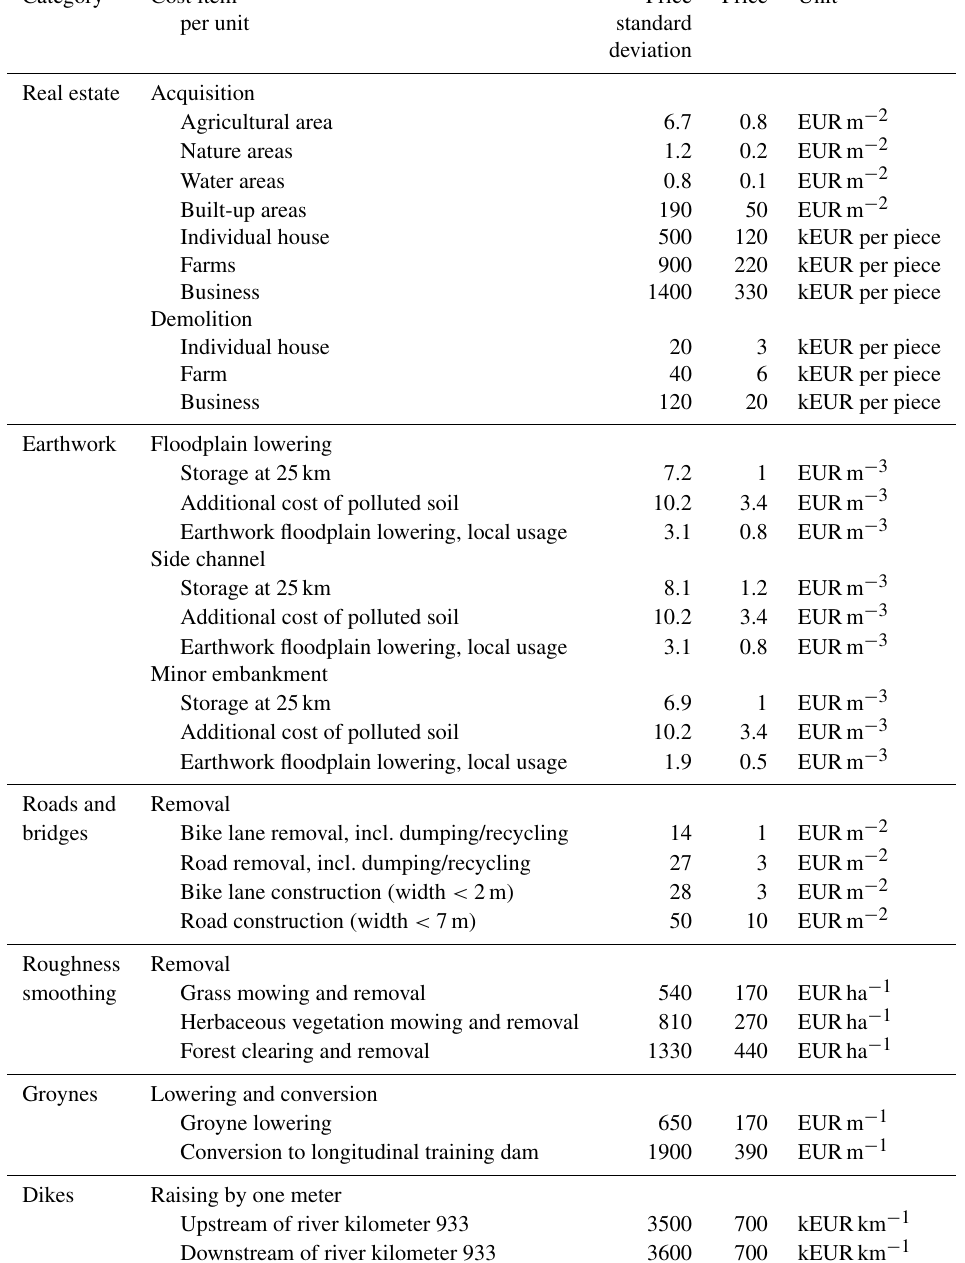
Table A1. Nonrecurring costs of measure implementation in unit prices. The unit prices represent the 2015 price level and exclude VAT and indirect costs for engineering, design, and unexpected costs. “kEUR” denotes